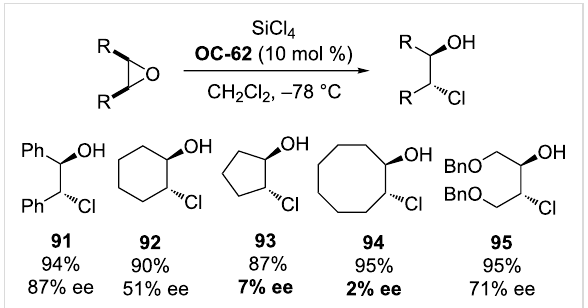
phosphorus/silicon cation, and then followed by an attack with the chloride ion in an S N 2 fashion to furnish chlorohydrin enantioselectively (Figure 14).